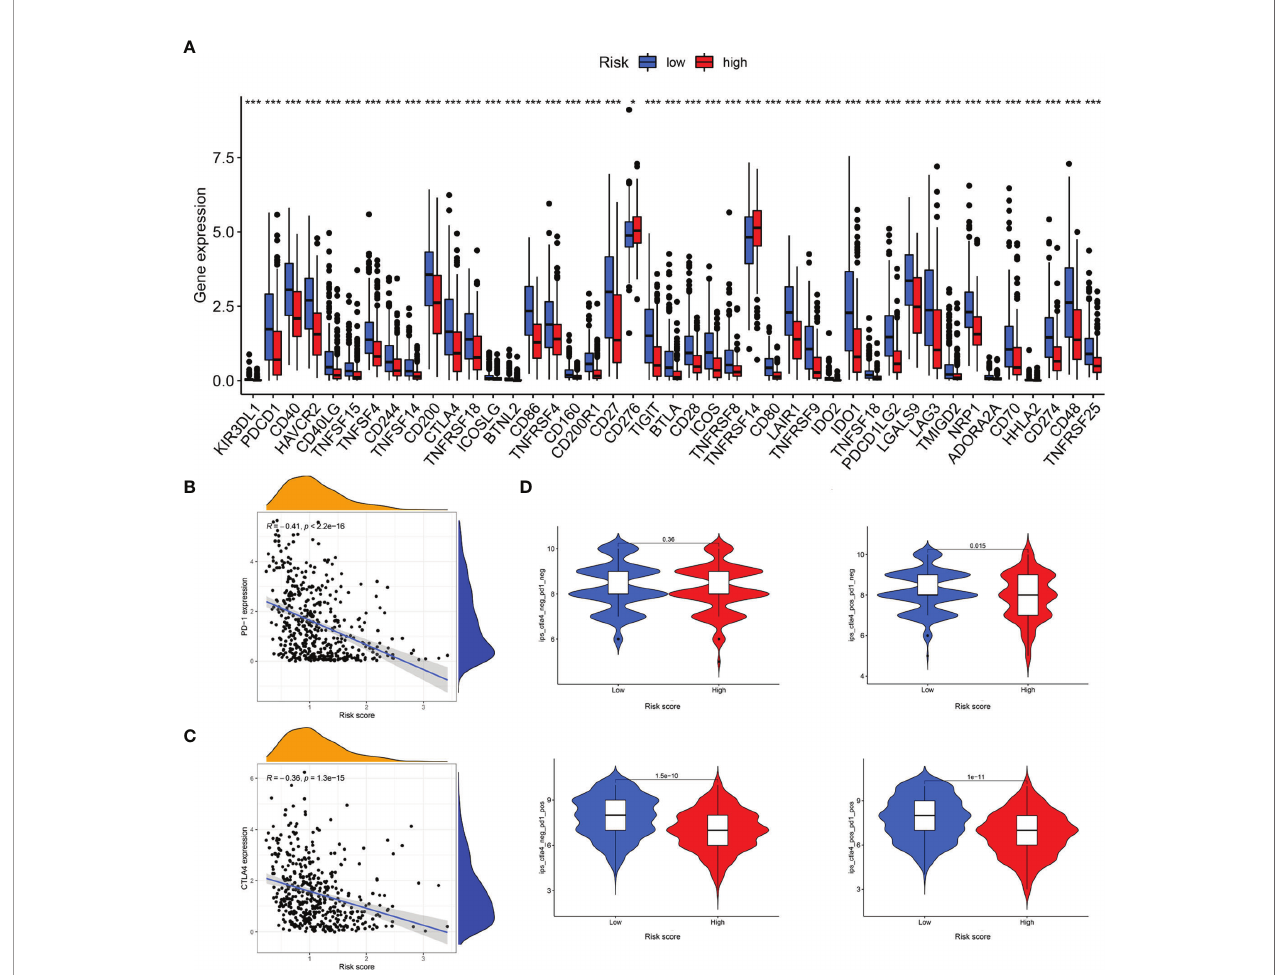
FIGURE 11 | Analysis of immunotherapeutic responses between different risk groups. (A) Expression of ICIs in different risk groups. (B) The correlation between risk score and PD-1 expression. (C) The correlation between risk score and CTLA4 expression. (D) IPS scoring scheme estimates the potential responses to immunotherapy in different risk groups *P < 0.05; ***P <